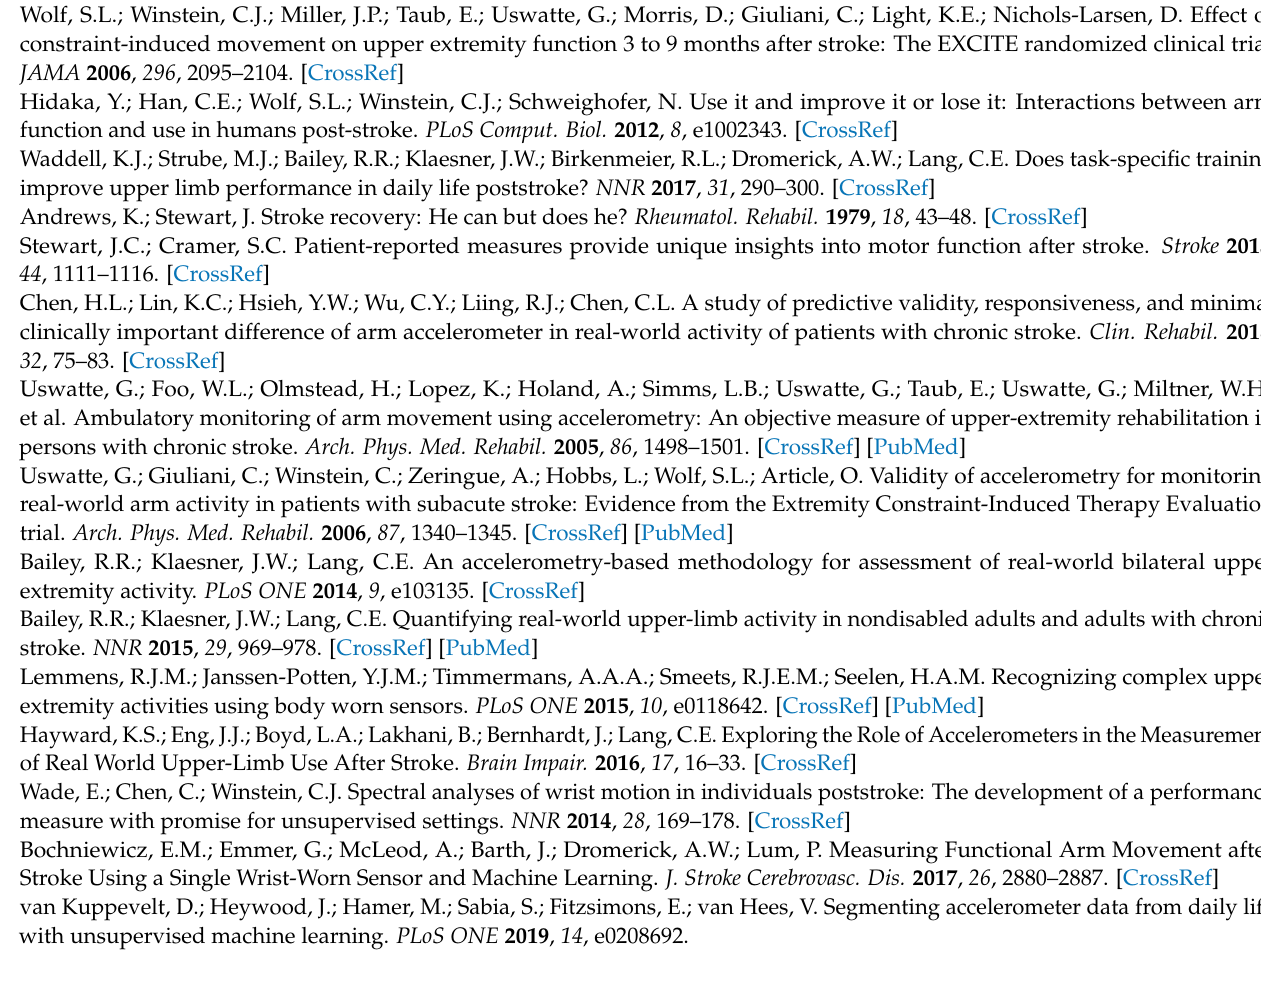
Figure 2. Flow chart of data availability. Figure A2. Flow chart of data